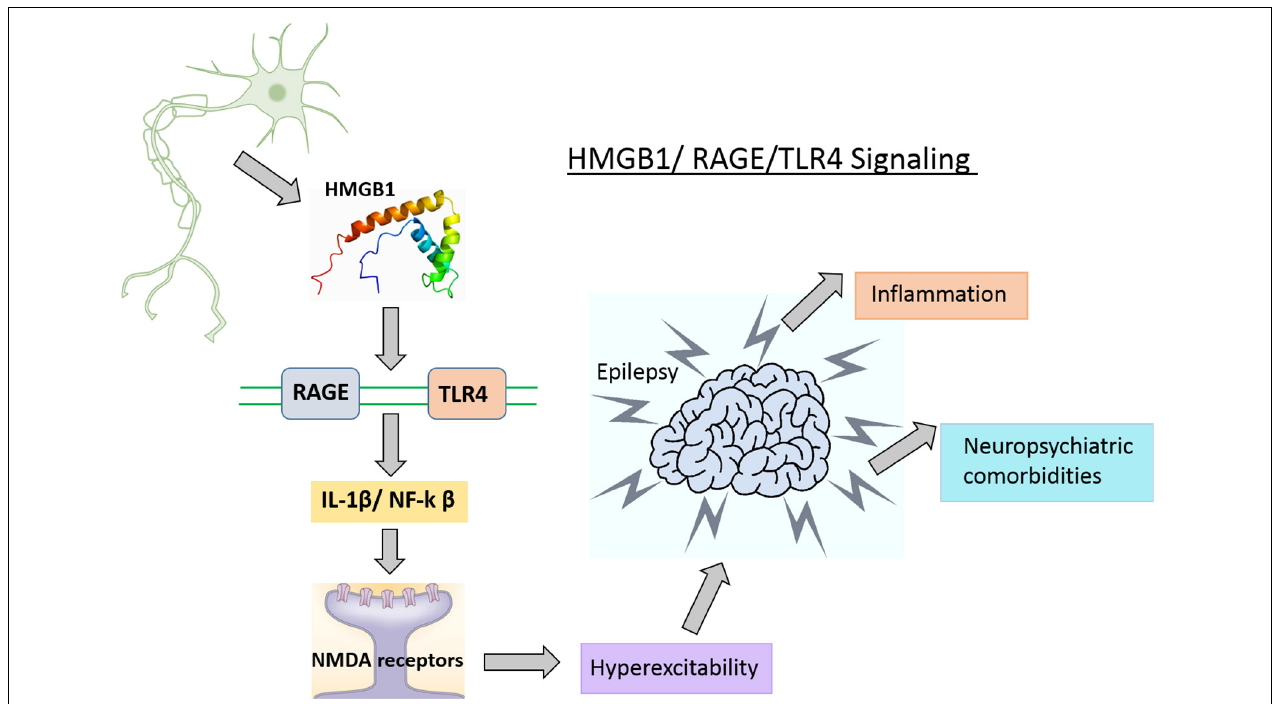
FIGURE 4 | HMGB1/TLR4/RAGE signaling in epilepsy. HMGB1 released from glia and neuronal cells in the CNS, activates its main receptor (TLR4 and RAGE) and contributes to epileptogenesis possibly via BBB disruption and activation of neuroinflammatory